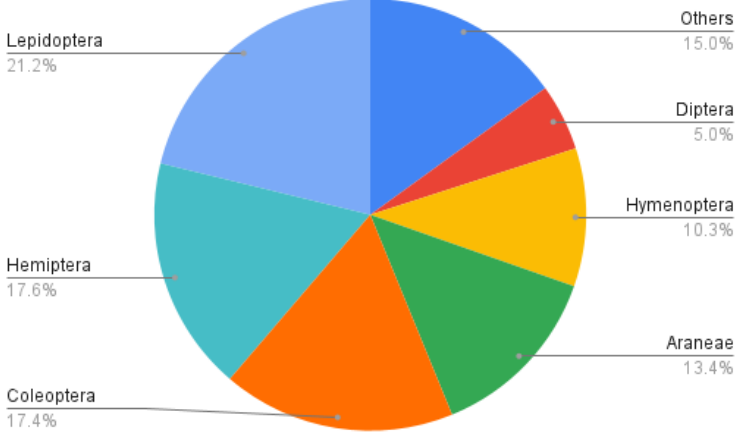
Figure 2. Order-level taxonomic distribution of identification requests received by the Montreal Insectarium’s Entomological Information Service in 2010, 2011, 2017, and 2018.